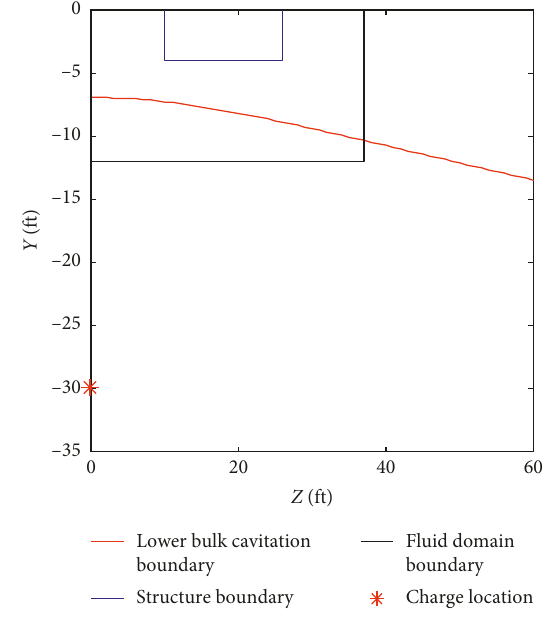
Figure 7: Problem configuration.